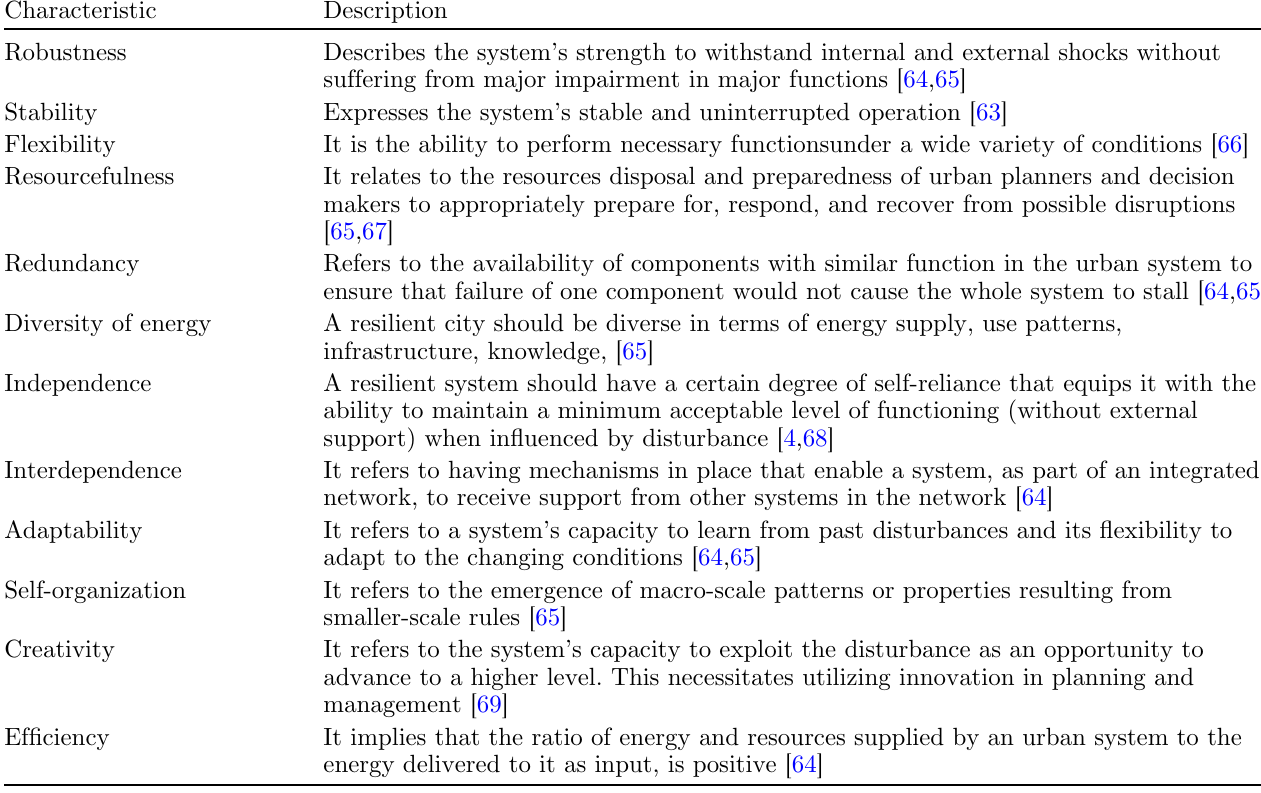
Table 4. Characteristics of resilient